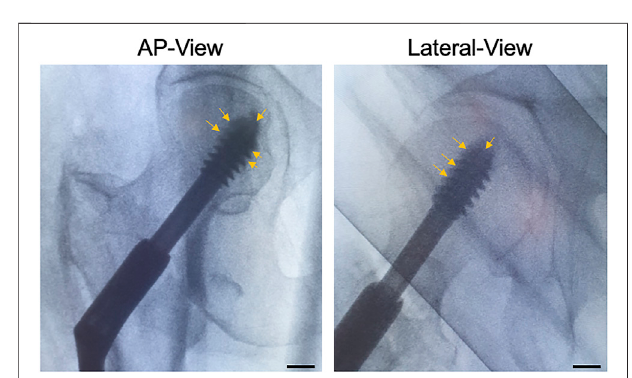
FIGURE 6 | CaS/HA spreading around the lag-screw in patients undergoing pertrochanteric fracture fi xation using a sliding lag-screw and a femoral plate. Arrows indicate the radio dense CaS/HA material around the lag-screw-bone interface. Scale bar indicates ~1.3